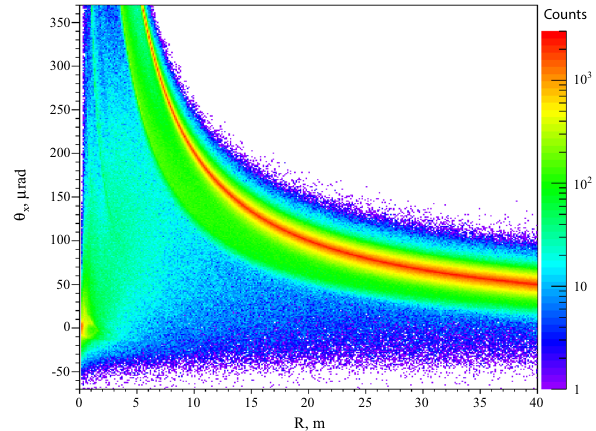
Fig. 6 The dependence of the number of positrons deflected on the angle θ x on the radius of curvature of the crystal for the (cid:2) 110 (cid:3) crystal orientation with respect to impinging particles